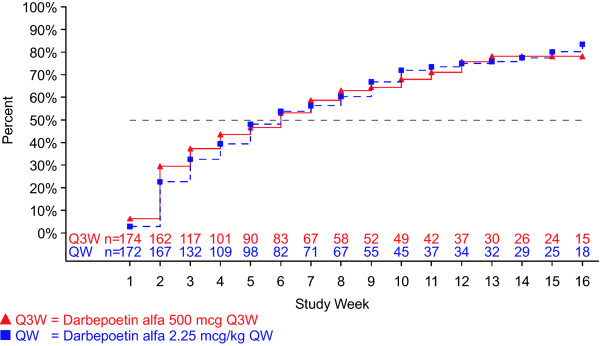
Time to hemoglobin concentration ≥10 g/dL for patients with baseline hemoglobin < 10 g/dL. Hemoglobin (Hb) measurements within 28 days of a red blood cell transfusion or whole blood transfusion were excluded. Patients not achieving a Hb level ≥10 g/dL between day 1 and end of the treatment period (EOTP, earlier of day 109 or end of study) were censored at their last Hb measurement prior to EOTP.